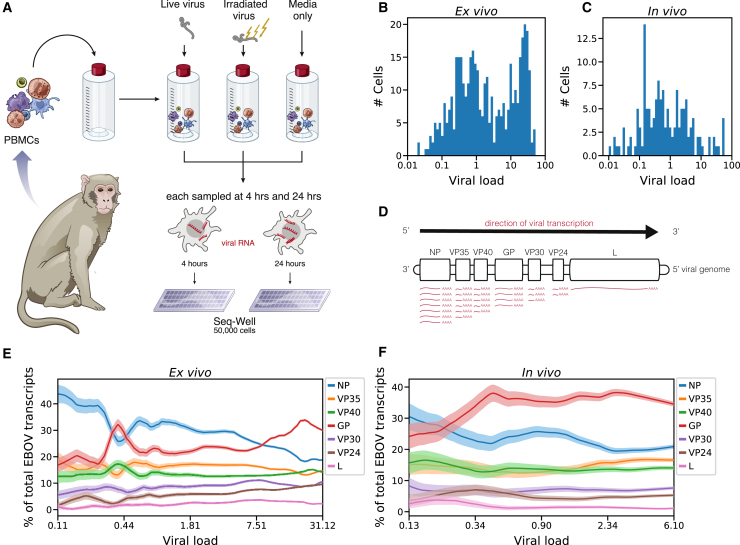
Viral Transcriptional Dynamics of Infected Monocytes In Vivo and Ex Vivo(A) Schematic of EBOV challenge of PBMCs ex vivo. See also Figure S7.(B and C) Percentage of cellular transcripts derived from EBOV (intracellular viral load) in monocytes from PBMCs inoculated with live virus ex vivo (B) or from PBMCs of NHPs infected in vivo (C). See also Figures S8A–S8D.(D) Schematic of EBOV transcription. The viral RNA-directed RNA-polymerase transcribes each gene sequentially but occasionally releases the genomic RNA template, ending transcription. As a result, transcription frequency decreases from NP to L.(E and F) Proportion of each EBOV gene versus viral load (log10 scale), ex vivo (E) or in vivo (F). We ordered infected monocytes by viral load and averaged the percentage of each viral gene over 50-cell sliding windows. Bands: mean ± 1 SD. See also Figures S8E and S8F.